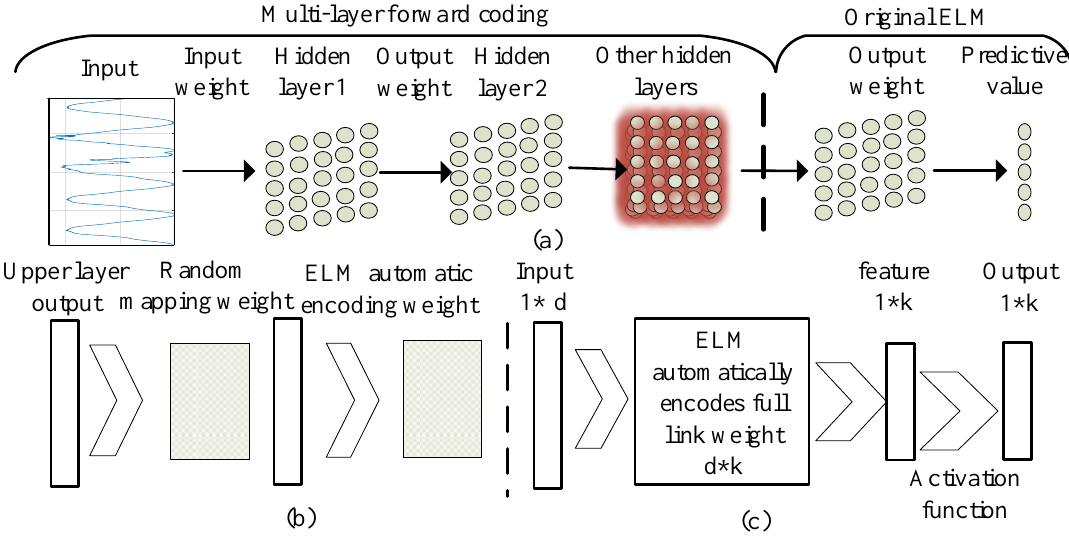
Figure 1. Hierarchical extreme learning machine (H-ELM) learning algorithm: ( a ) H-ELM overall framework; ( b ) ELM automatic coding implementation; ( c ) H-ELM single hidden layout .